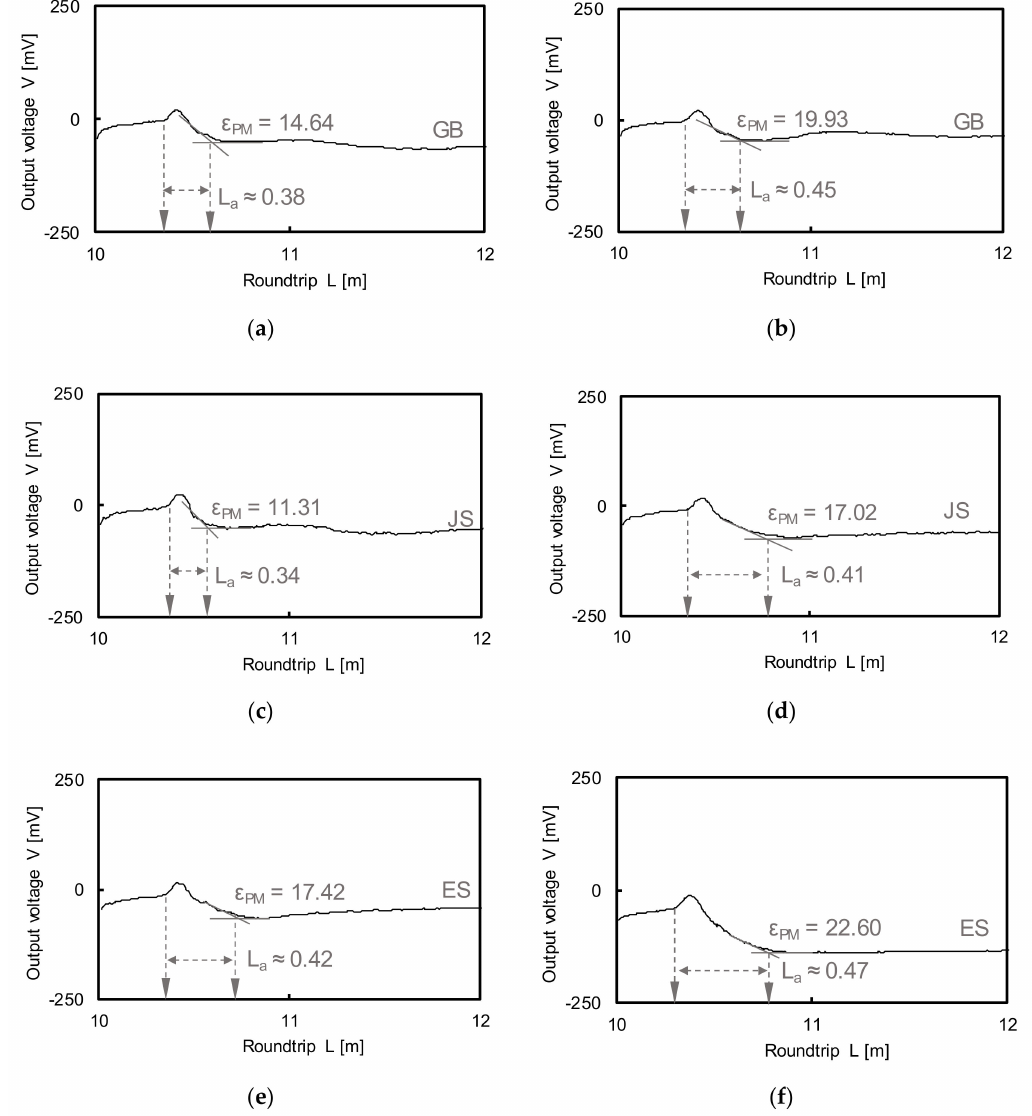
Figure 7. Waveforms of each specimen with dielectric constants: ( a , c , e ) relative density of 40%; ( b , d , f ) relative density of